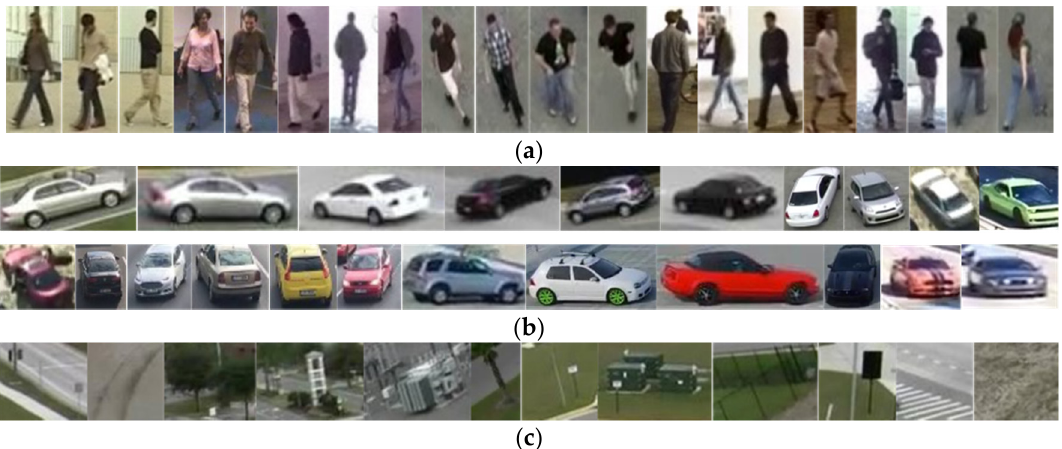
Figure 4. Examples of positive images: ( a ) Person, ( b ) car, ( c ) non ‐ moving object.